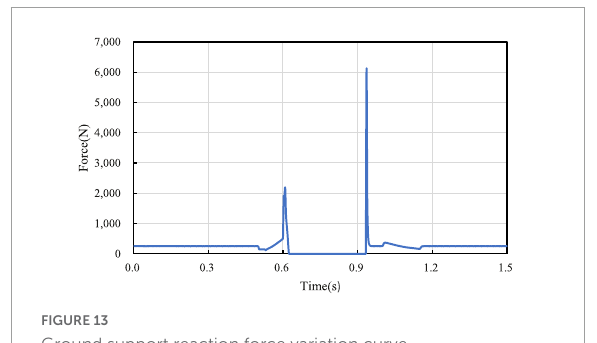
FIGURE13 Ground support reaction force variation